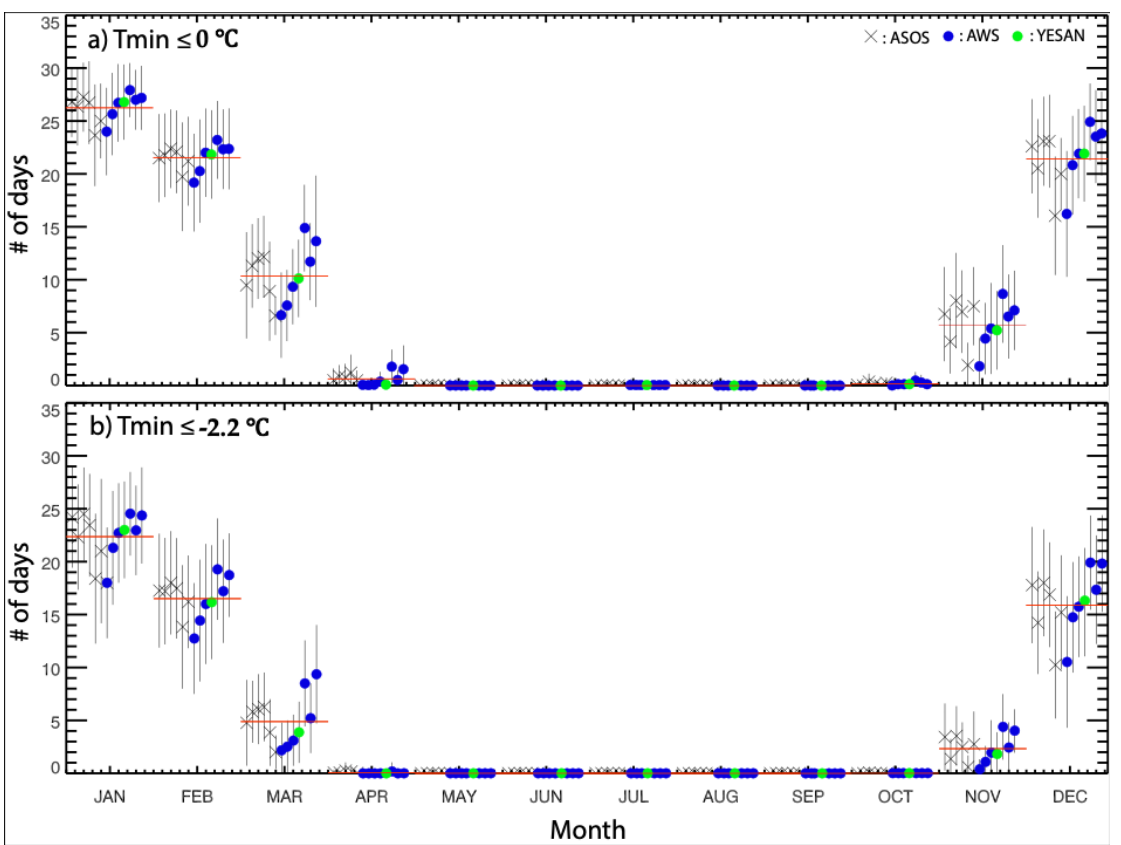
Figure 3. Number of days with the minimum temperature (Tmin) ( a ) below 0 ◦ C and ( b ) below − 2.2 ◦ C noted at each observation station (x, ASOS; blue filled circle, AWS; and green filled circle, YESAN). Red lines represent the average of the 13 stations for each month and black bars show standard variation of each